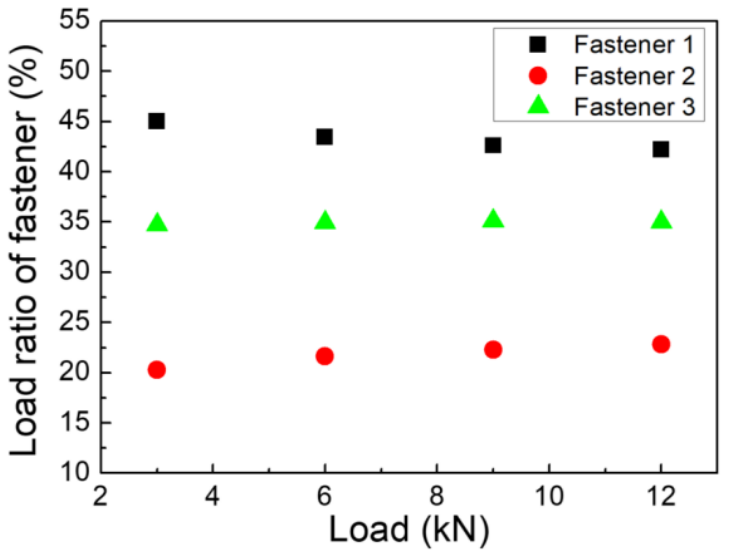
Figure 8. Variation of the pin-load distribution ratio of fasteners with the applied load in the three- bolt joint.